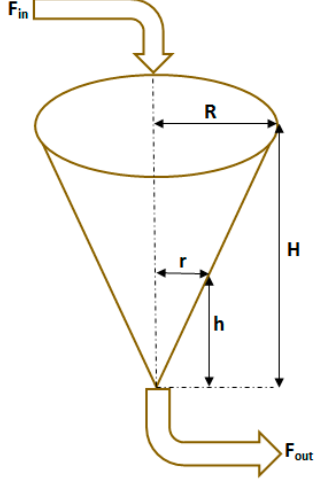
Figure 5. Conical tank model [35].